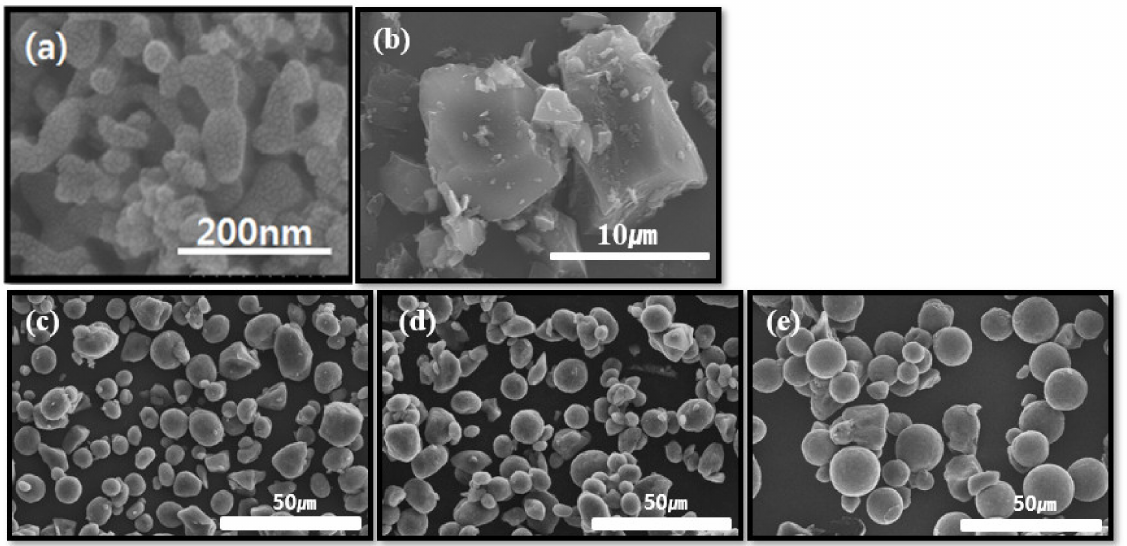
Figure 1. SEM images of ( a ) nano silicon, ( b ) hard carbon, ( c ) HSC, ( d ) HSBC, and ( e ) HSBGC.